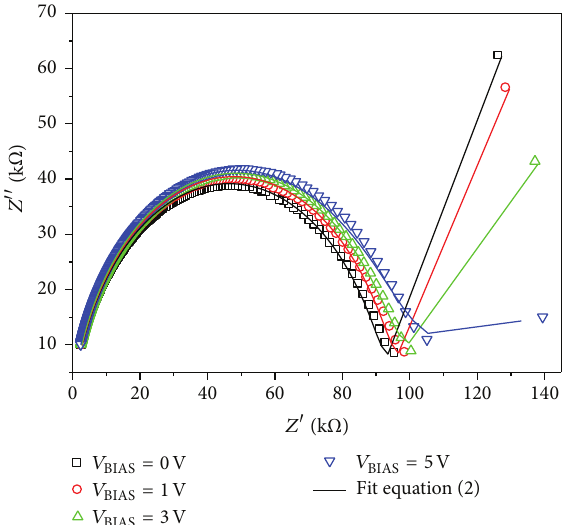
Figure4:Timeevolutionoftheoutputvoltagewithaloadresistance ( 𝑅 𝐿 ) of 10 M Ω , measured at room temperature.